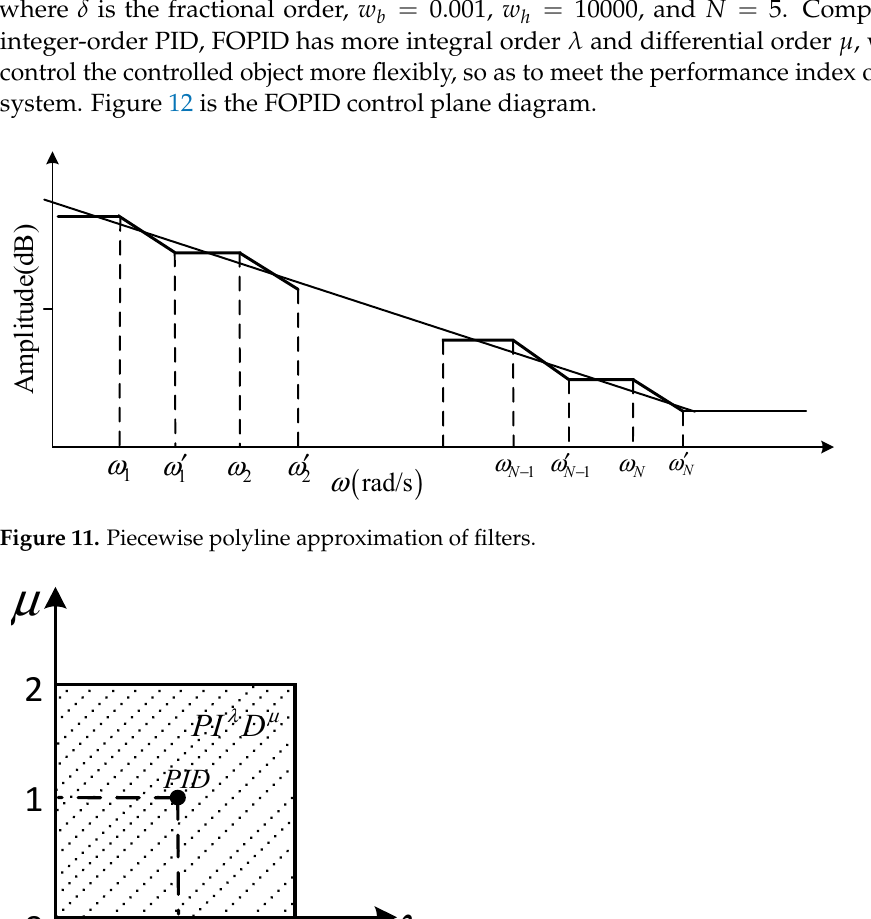
represent the zero and pole re-